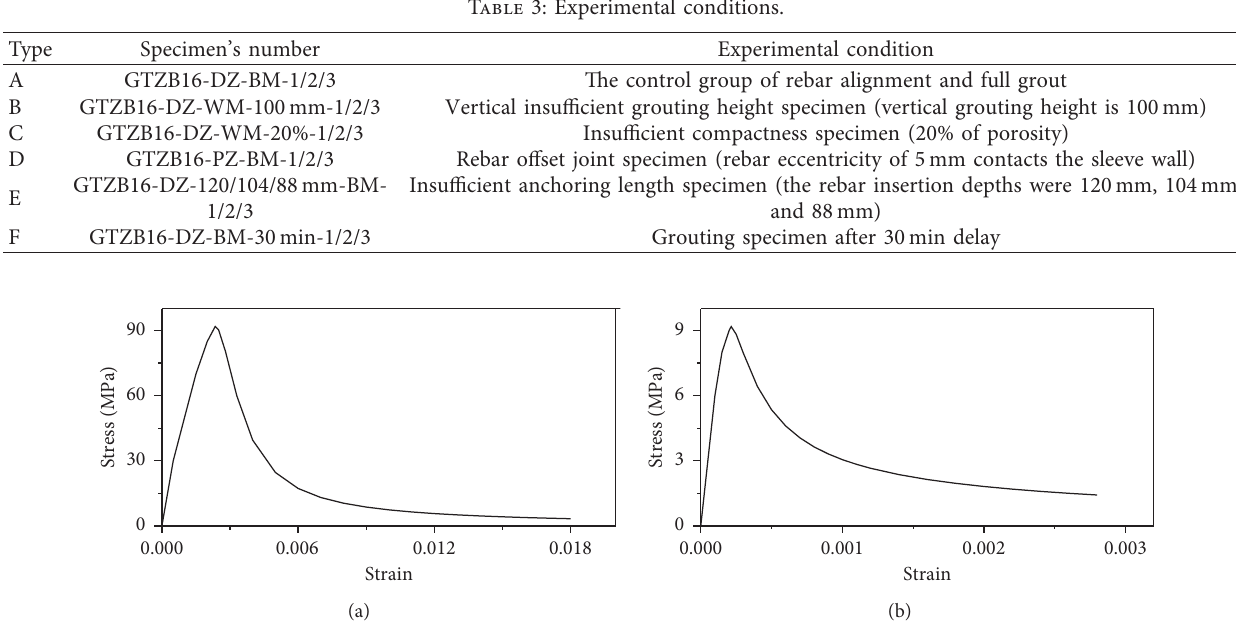
Figure 4: Stress-strain curve of grout: (a) uniaxial compression of concrete; (b) uniaxial tension of concrete.